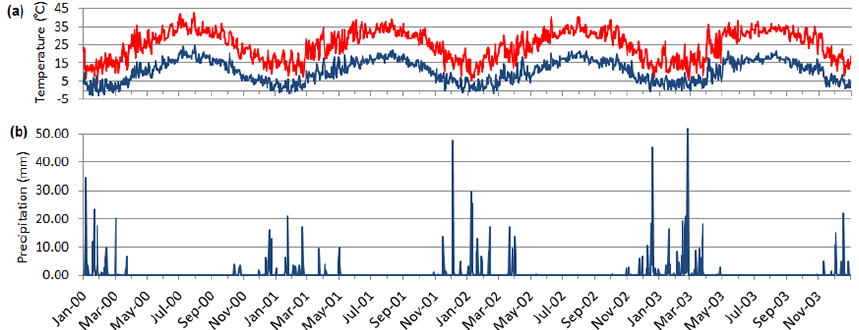
Figure 6. (a) Daily minimum and maximum temperature of Qatraneh station; (b) daily precipitation of Amm ¯ an Airport gauge, for the period